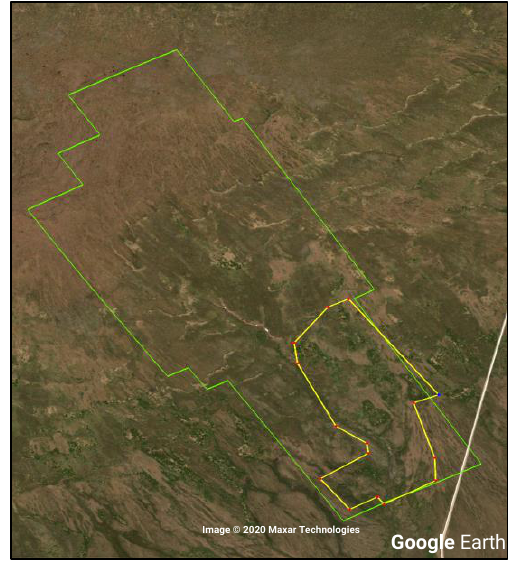
Figure 1. Teller watershed mapping extent in 2017 (green) and 2018 (yellow). Image footprint is approximately 3km by 2km. Teller road shown in white. Map data: Google, Maxar Technologies.